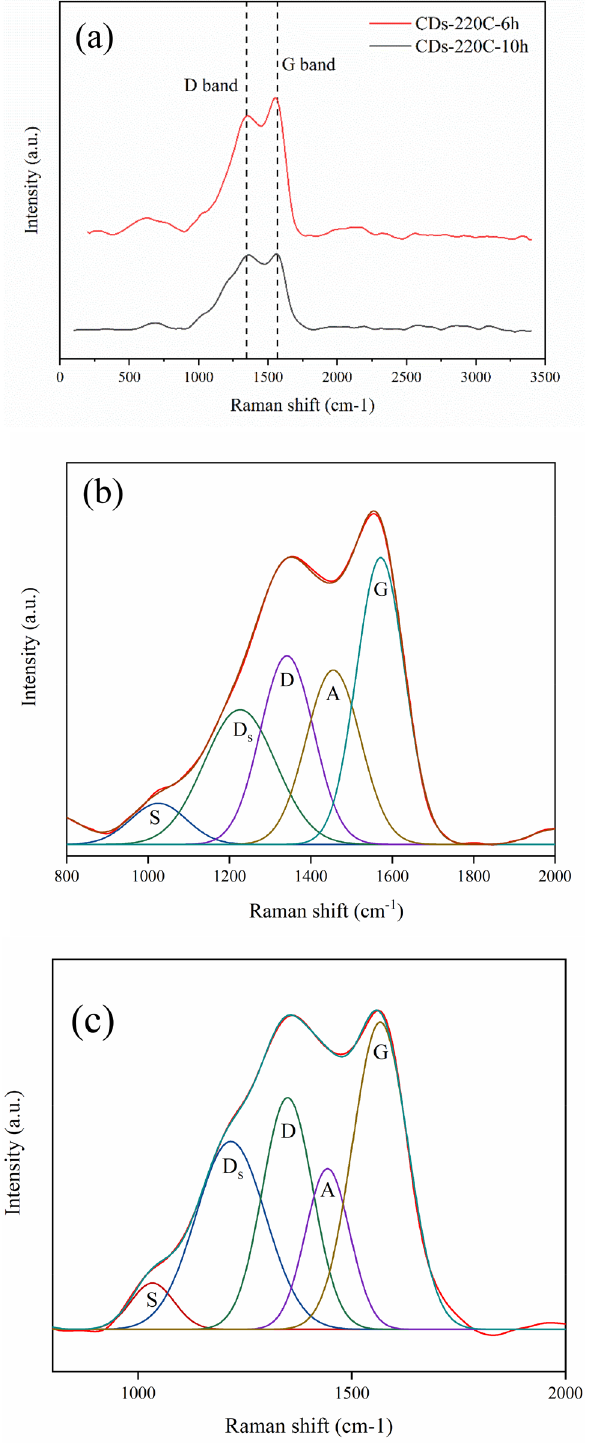
Figure 2. Raman spectra of ( a ) CDs-220C-6h and CDs-220C-10h, Deconvolution of Raman spectra of ( b ) CDs-220C-6h, and ( c )